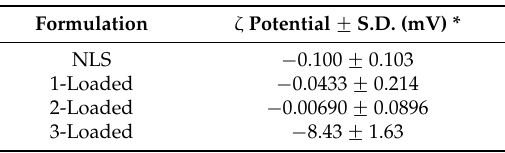
Table 2. Zeta potential of the NLS and copper(II) complexes loaded into the NLS. Each value is the average ( ˘ standard deviation) of three